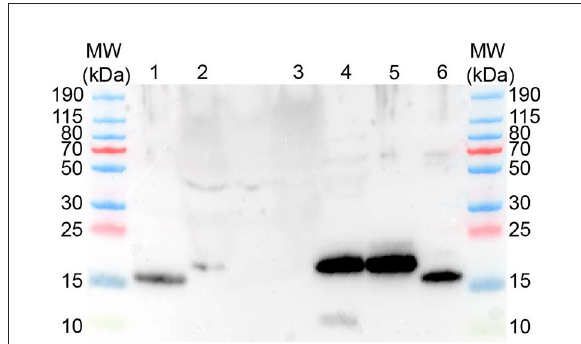
FIGURE5 Western blot using rabbit anti-human REG3A antibodies yields protein bands of approx. 16-17 kDa. MW–Molecular weight marker; 1–human recombinant REG3A; 2–canine plasma (sepsis); 3–canine plasma (healthy control); 4–canine